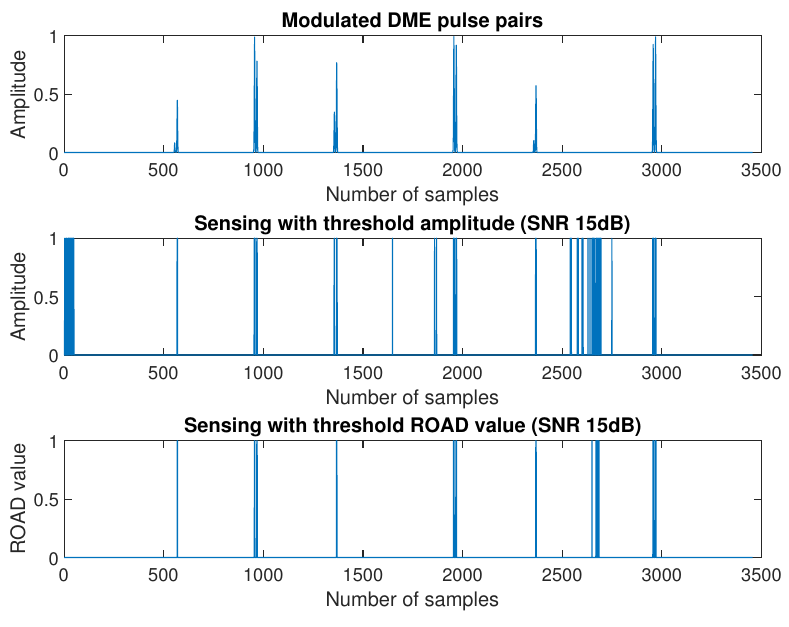
Figure 13. DME interference ( Top ), threshold amplitude-based sensing ( Middle ) and threshold ROAD value-based sensing ( Bottom ) for an SNR of 15